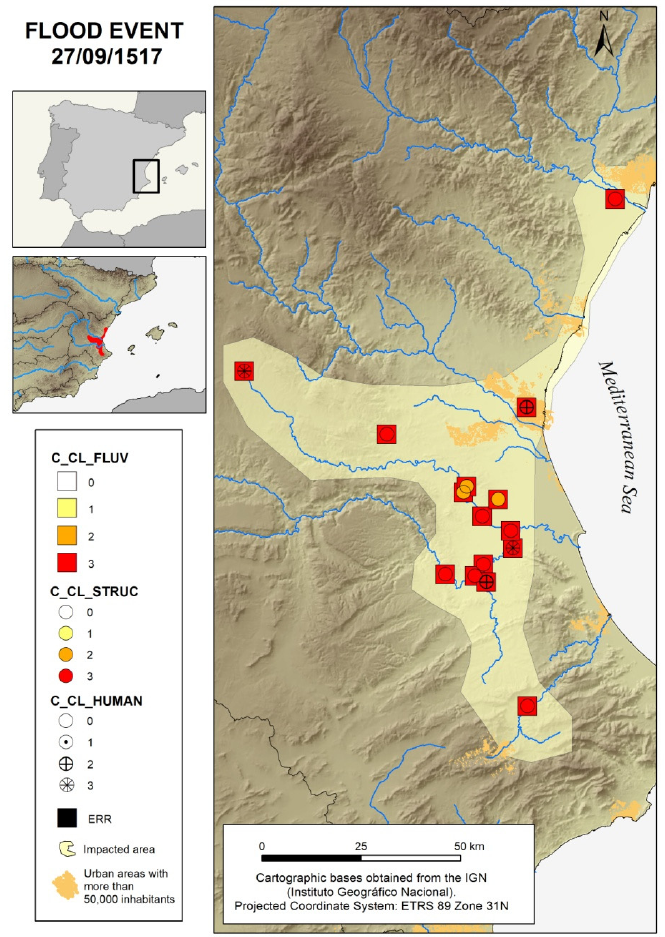
Figure 1. Representation of cases for the flood event of 27 September 1517. C_CL_FLUV: Variable 1. Hydraulic behaviour of the river flood. C_CL_STRUC: Variable 2. Flood impact on structural elements. C_CL_HUMAN: Variable 3. Social/personal vulnerability to the flood. ERR: Erroneous or spurious cases. Blue line: Basic fluvial system. Black line: Spanish Hydrographic Demarcations. Urban areas: Population according to 2022 demographic record.